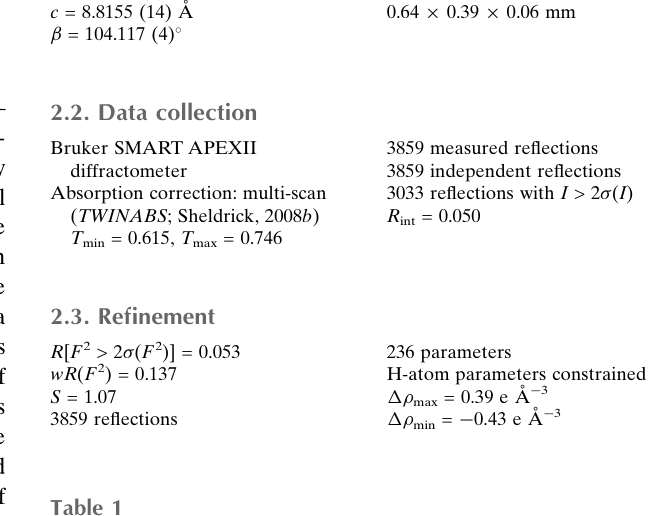
Hydrogen-bond geometry (A˚ , (cid:2)